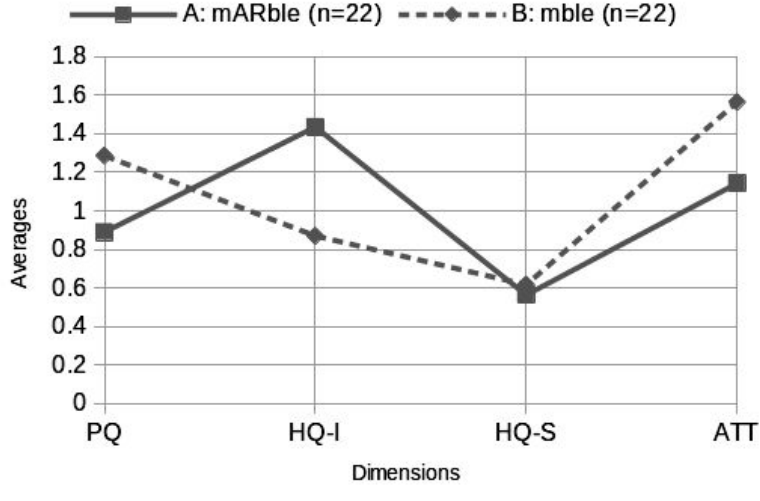
Figure 7. Average values calculated for the four qualities (both groups).